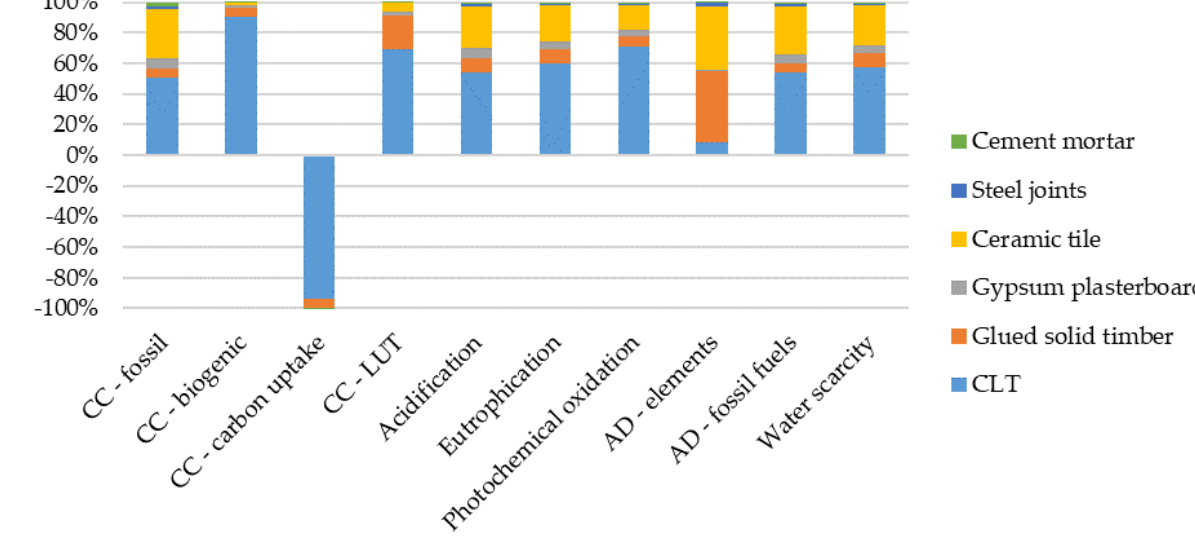
Figure 14. Impact assessment of inner walls construction materials.